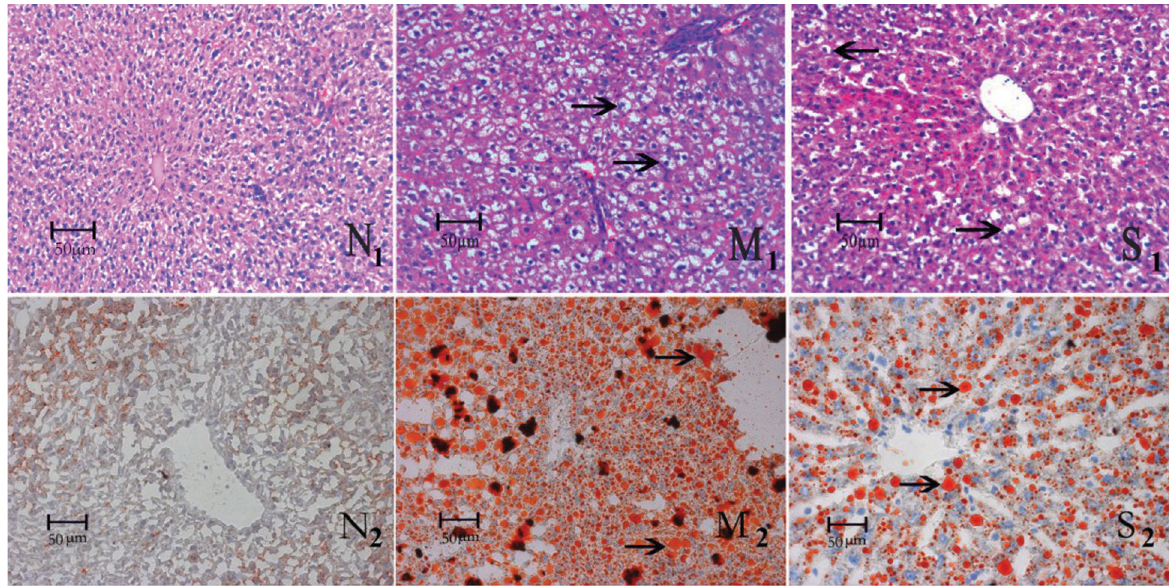
Figure 1. Pathological changes of rat liver stained with hematoxylin-eosin and Sudan III in each group. The micrographs show a mass of large fat granules (black arrows in Panel M 1 ), which represent steatosis in the liver of the group receiving a high-fat diet (HFD) for 6 weeks. Improvement could be seen in the silibinin group with fewer and smaller fat granules (black arrows in Panel S 1 ) and relatively regularly arranged cell cords. Pathologic evaluation showed more and larger fat granules stained salmon pink by Sudan III in the HFD group (black arrows in Panel M 2 ). Fewer and smaller fat granules could be seen in the group treated with silibinin (black arrows in Panel S 2 ). N = control